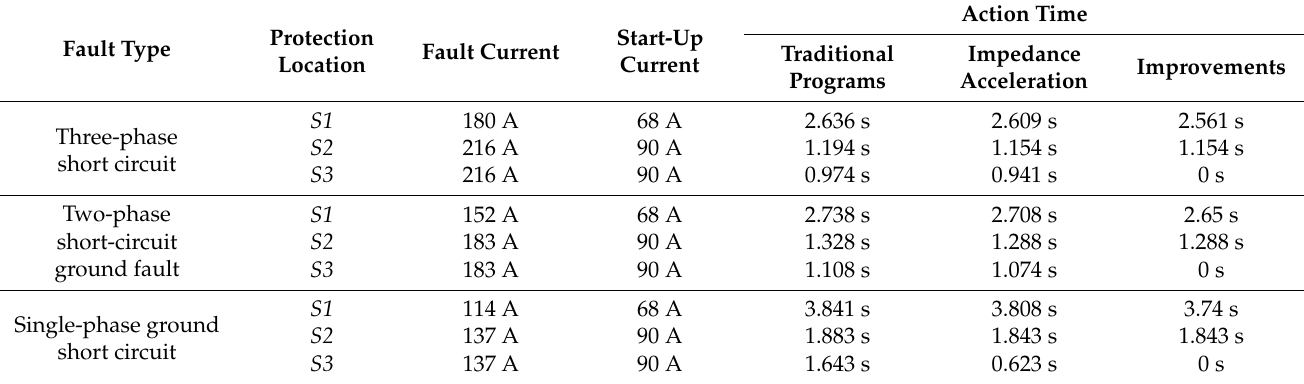
Table 4. Operating time of different protection schemes in the case of line CD via 50 Ω ground resistance fault.